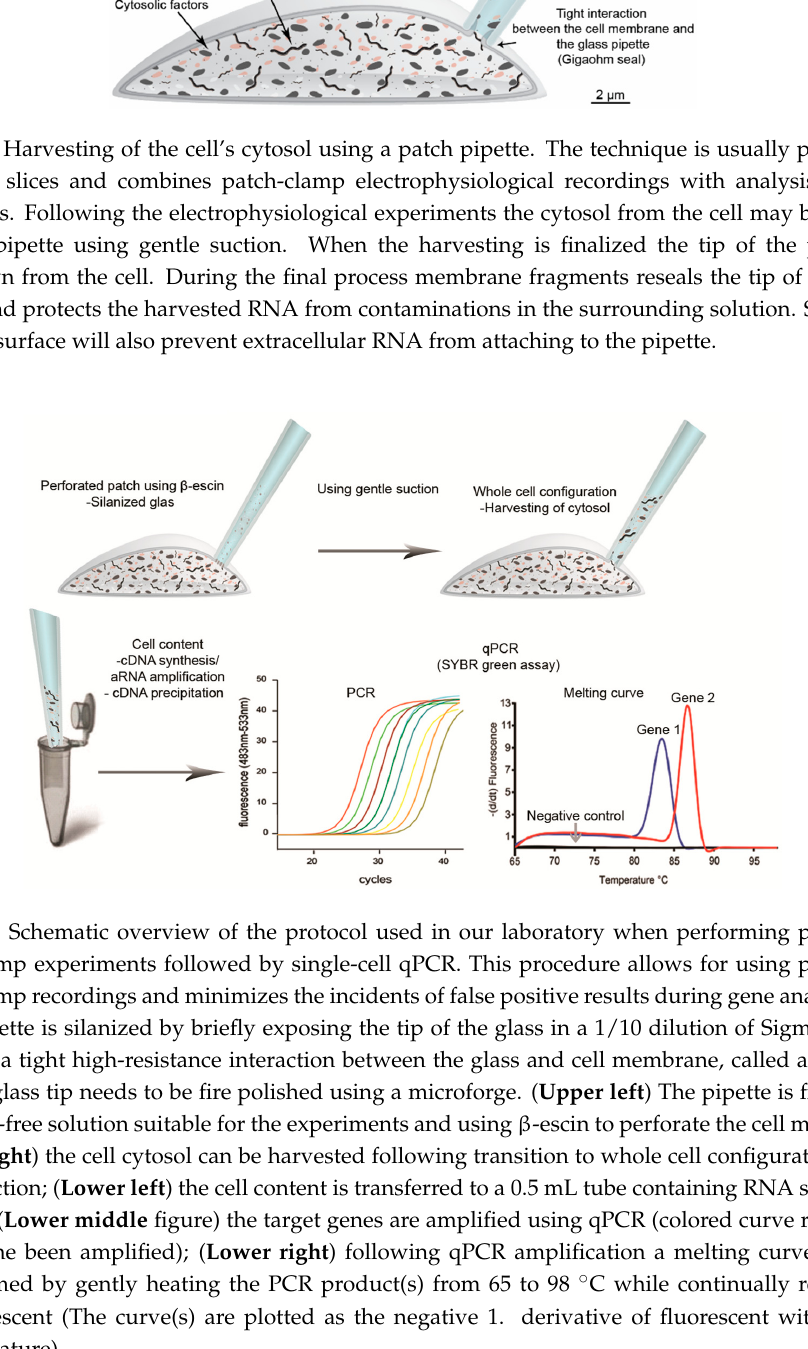
be used with caution.